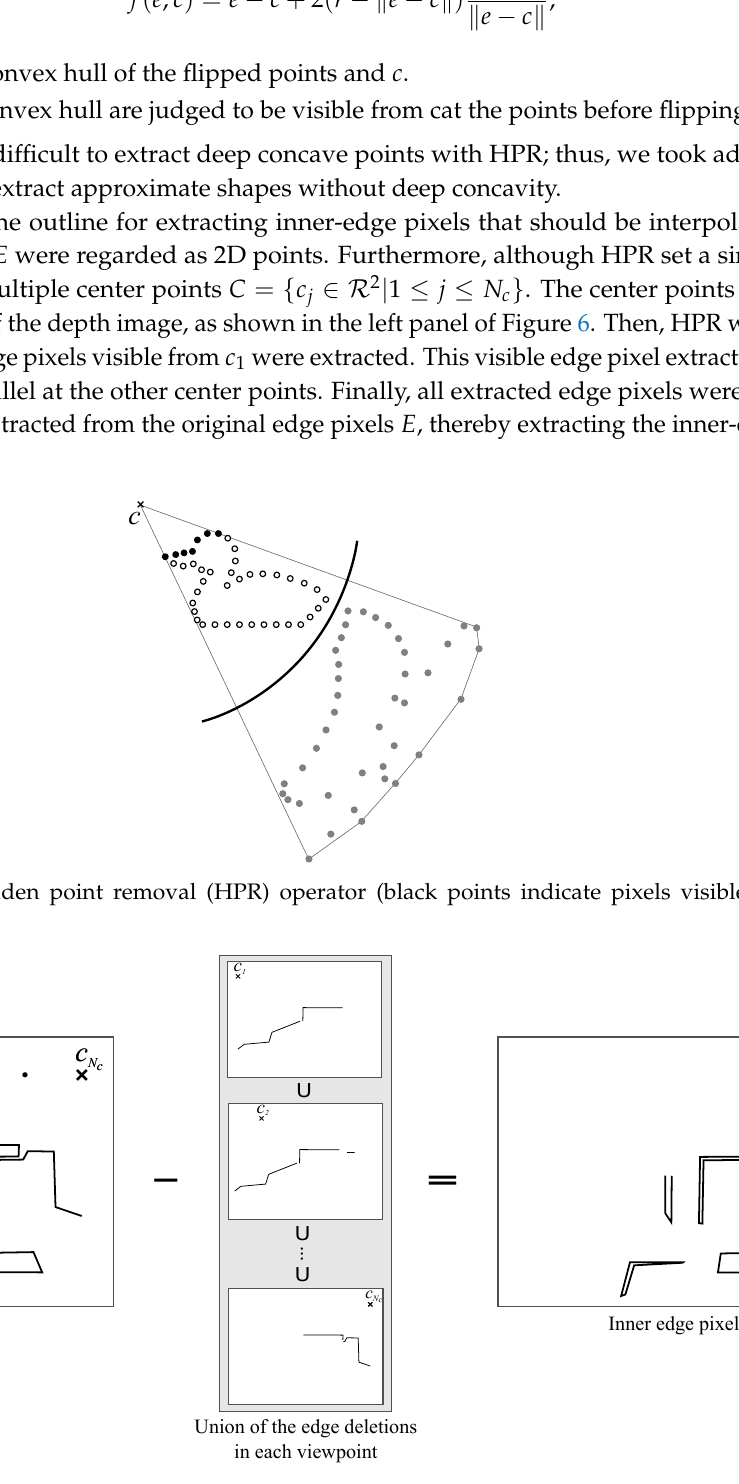
Figure 6. Inner-edge pixels after eliminating outer